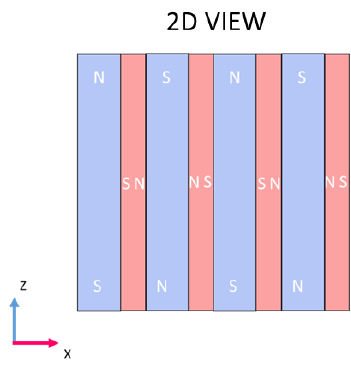
Figure 4. Magnetic assembly design of the EMAT probe with the “Klaus Halbach” design.